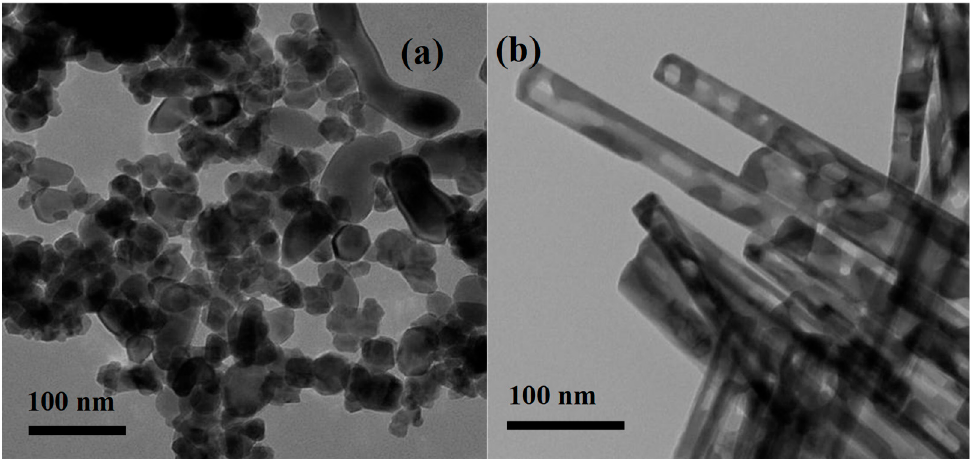
Figure 1. TEM images of CuFe 19 O x prepared with the co-precipitation ( a ) and aqueous precipitation ( b ) methods.